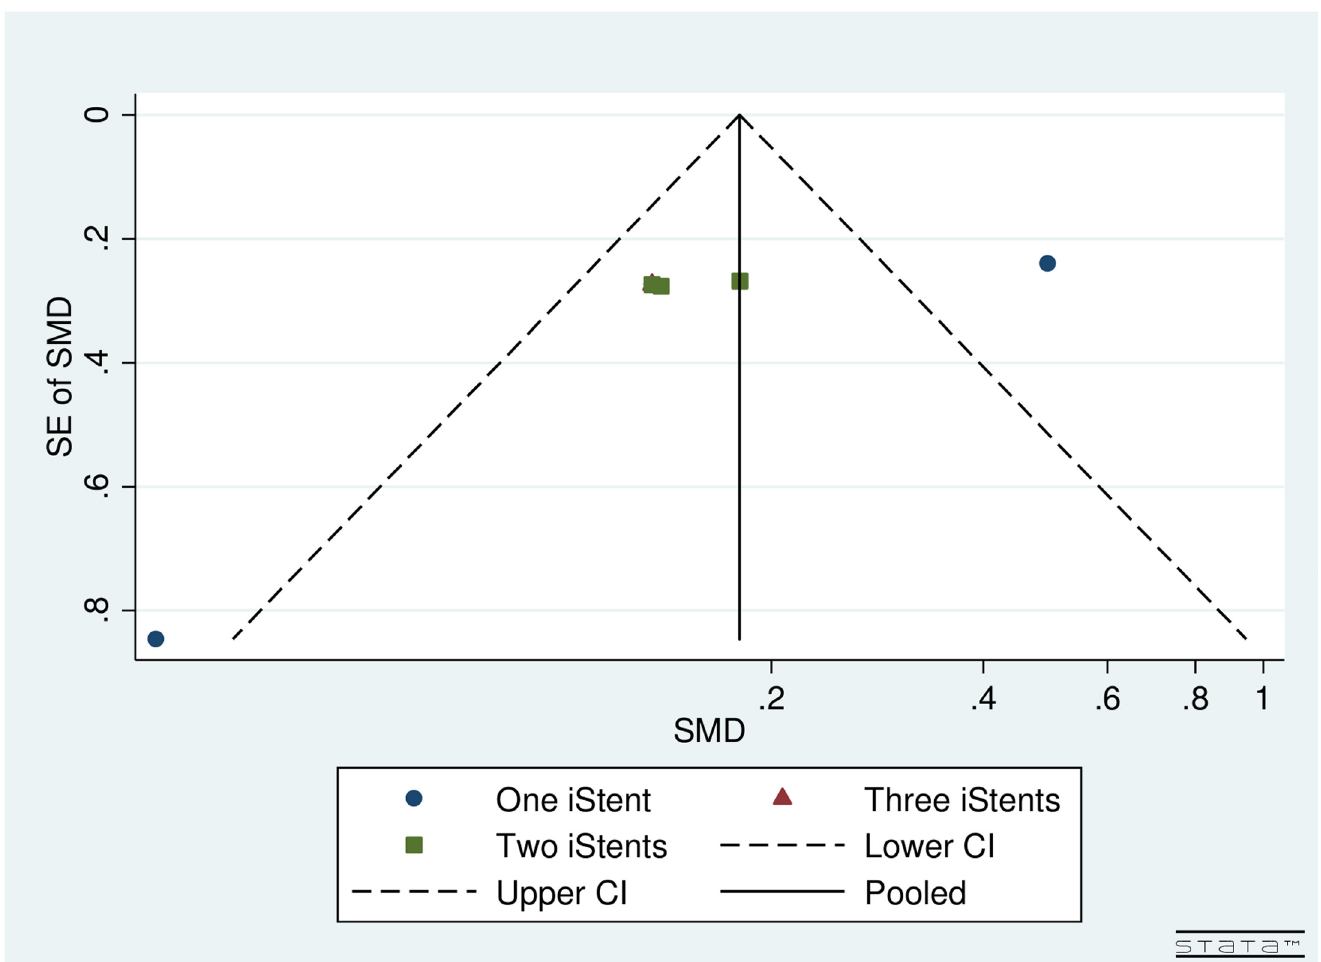
Fig 5. Funnel plot for studies examining pre- and post-operative number of medications by number of iStents